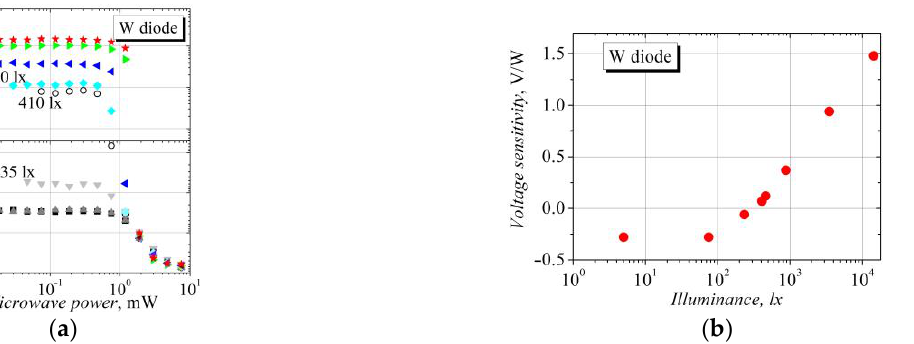
Figure 6. ( a ) Dependence of voltage sensitivity of the W-diode on incident microwave power at different white-light illuminance values. ( b ) Dependence of voltage sensitivity on illuminance at low microwave power.